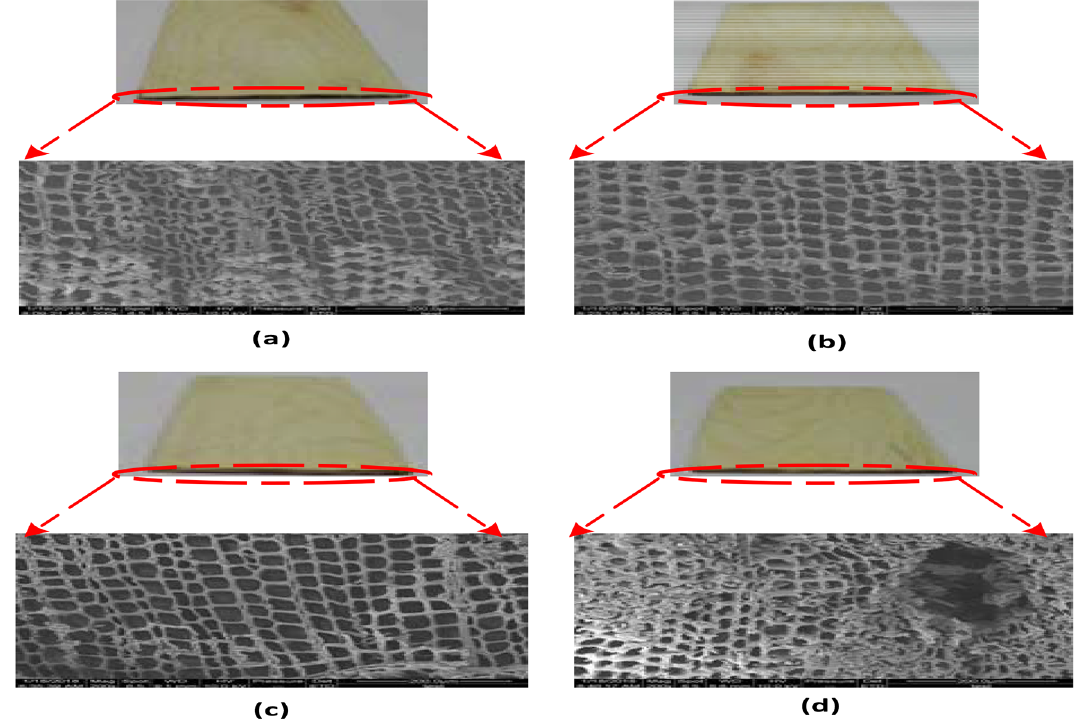
Fig. 9 Effects of laser power on the cutting surface of Korean pine (Pinus Koraiensis) a At 4 W, b At 6 W, c At 8 W, d At 10 W